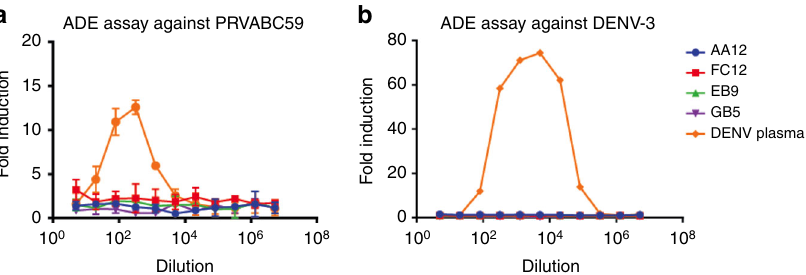
Fig. 3 NS1-speci fi c antibodies do not cause antibody-dependent enhancement (ADE) of infection in vitro. To examine whether enhancement of fl avivirus infection in vitro is observed, ZIKV NS1-speci fi c mAbs or pooled serum from a DENV positive donor were incubated with a PRVABC59 or b DENV-3 viruses and added to Fc γ R bearing K562 cells. All mAbs were tested at a starting concentration of 100 ng per mL and were serially diluted four-fold. DENV positive control sera was diluted fi ve-fold initially and serially diluted four-fold. The assay was run in duplicate and fold induction was measured as number of infected cells as measured by fl ow cytometry divided by infected cells with no antibody or serum added. Sera were obtained through a screening of blood donations in Puerto Rico as described previously in Bardina et al. 14 . Plotted values represent mean value and standard deviation